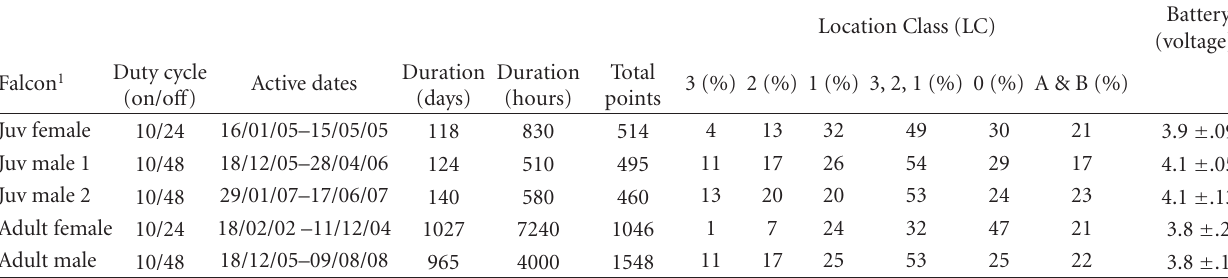
Table 3: Performance measures/operating details Technical details describing all five PTT’s.